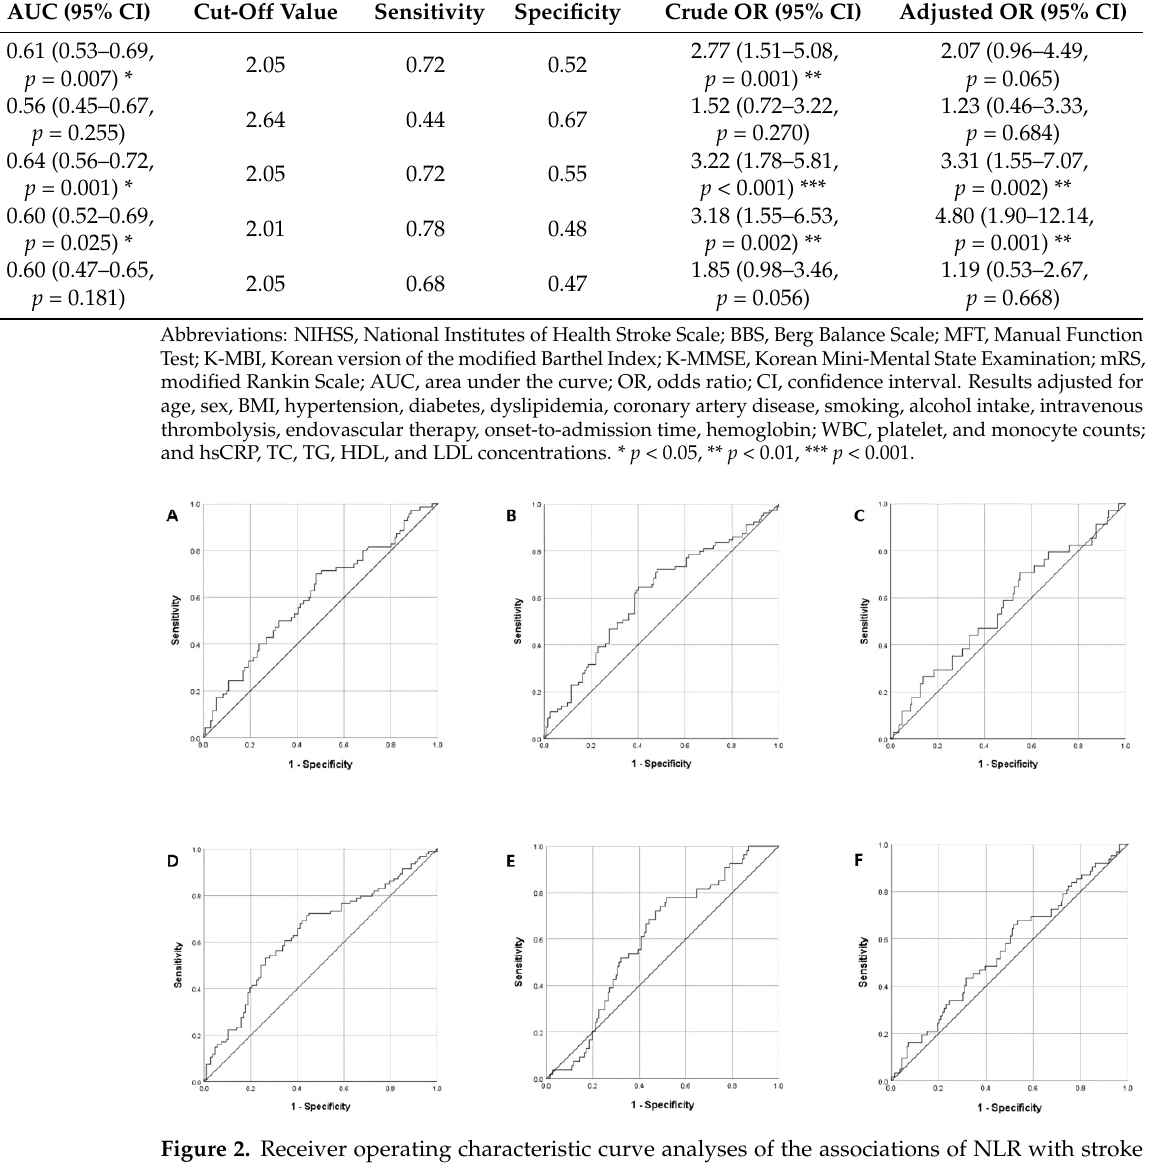
Table 5. Logistic regression analysis of the associations between the optimal NLR cut-offs and the indicators of stroke severity and functional outcomes.